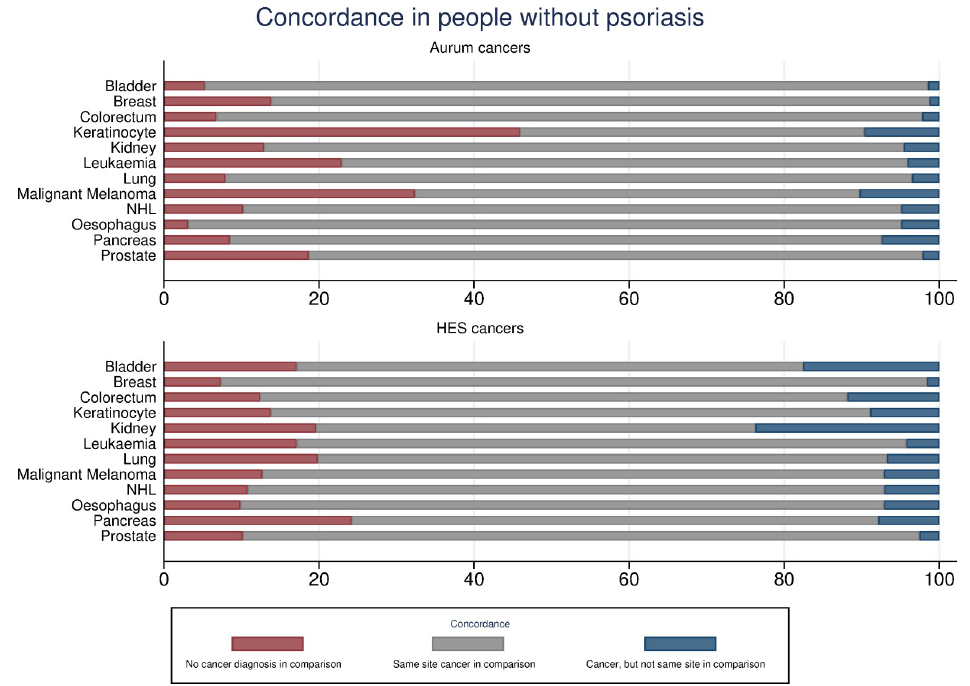
Fig 2. Concordance in cancer recording for Aurum-linked comparison